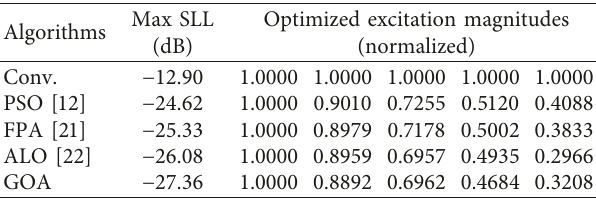
Figure 9: Array factor of 10-element linear array for example 3. Table 4: The maximum SLL of linear array and the location of each element after optimization.